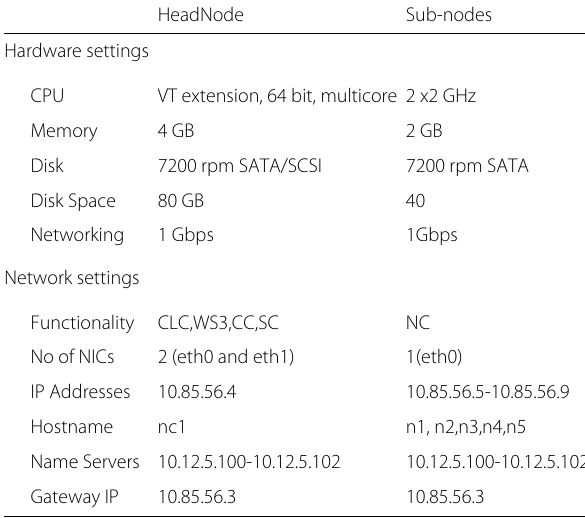
Table 1 Hardware and Network Configuration of the UEC HeadNode